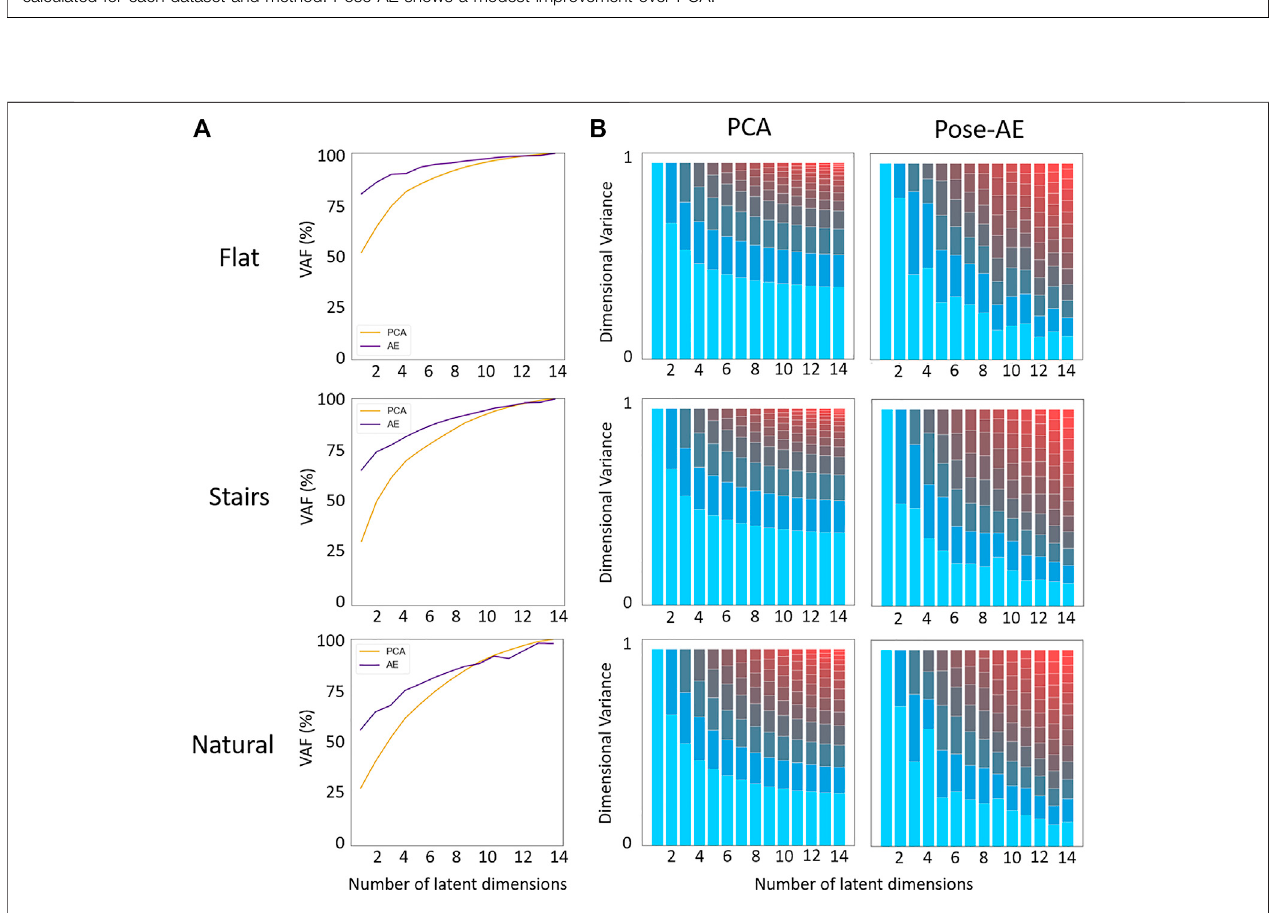
FIGURE 2 | (A) For each dataset, a randomly chosen sample was reconstructed using PCA and Pose-AE. Pose-AE produced qualitatively improved poses over PCA,thoughneitherwasabletoreconstructposesfromnaturalmovementsdataset,insteadelectingtoreconstructameanstandingpose. (B) RMSEofjointangleswas calculated for each dataset and method. Pose-AE shows a modest improvement over PCA.